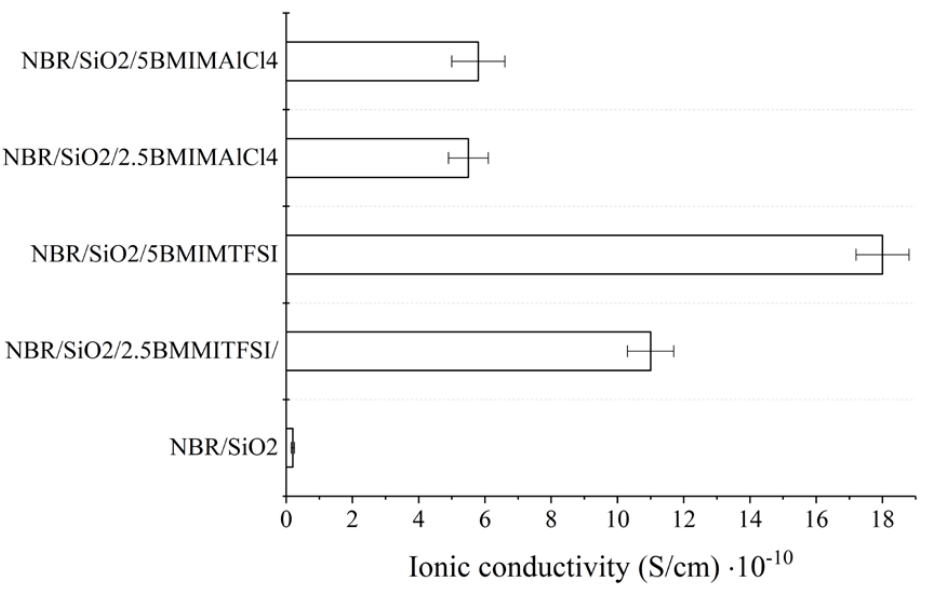
Figure 5. Ionic conductivity of NBR-ionic liquid-based composites measured at room temperature.